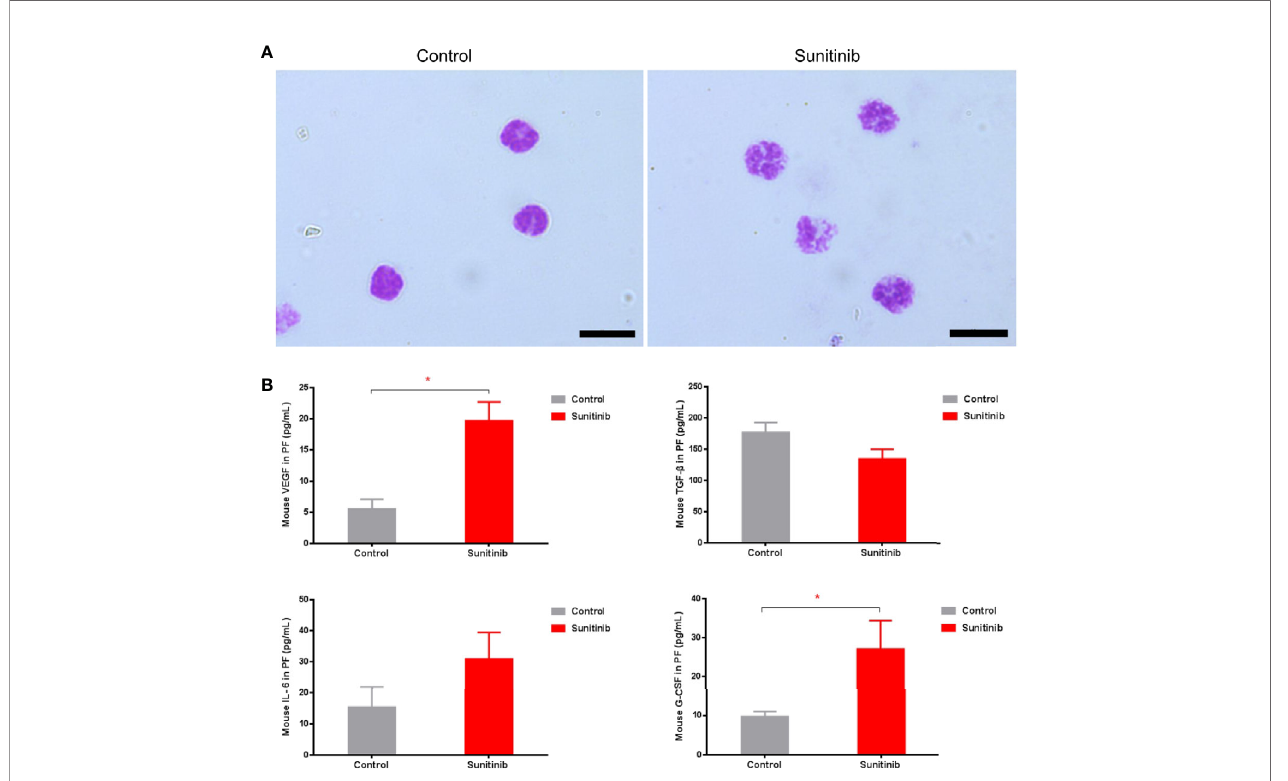
FIGURE 3 | Characteristics of G-MDSC cells and peritoneal cytokine after Sunitinib treatment. (A) Representative Wright-Giemsa staining of isolated peritoneal CD11b+ Ly6G+ G-MDSCs from at least 5 animals in each group after 7 days of treatment, Magni fi cation 1000× Oil, and Scale bar 10 m m. (B) Peritoneal cytokines VEGF, G-CSF, IL-6, TGF- b after 7 days of treatment. Data are expressed as the mean ± SEM from 10 animals in each group, *P <